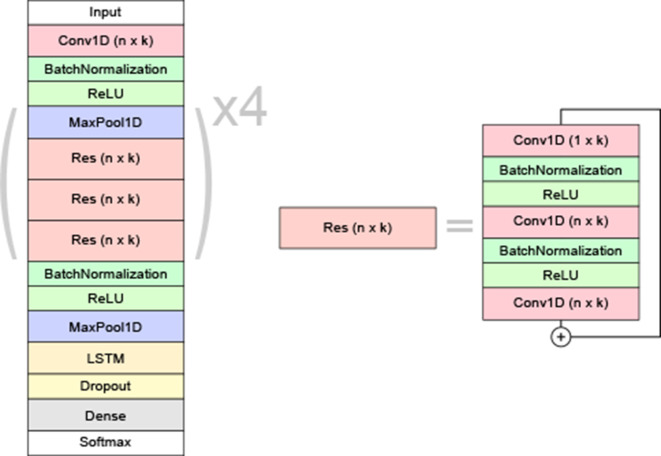
Schematic overview of the neural network model architecture.Each residual block (Res) is made up of 1D convolutional filters of size n × k with batch normalization and ReLU activations in between. The initial convolution after the input layer has the same hyper-parameters as the first residual block. A 1 × k convolution is added in each bottleneck unit for efficiency. The ‘+’ symbol denotes a skip-connection, where the residual block’s input is added to its output. The final convolved output goes to a bidirectional long short-term memory (LSTM) layer. For each frame, the outputs are distributed among the different classes by a dense layer with softmax activation.